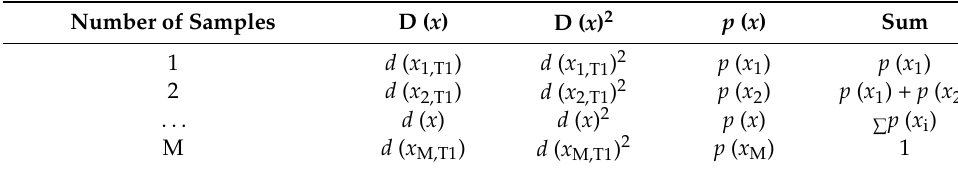
Table 2. Calculation information table of